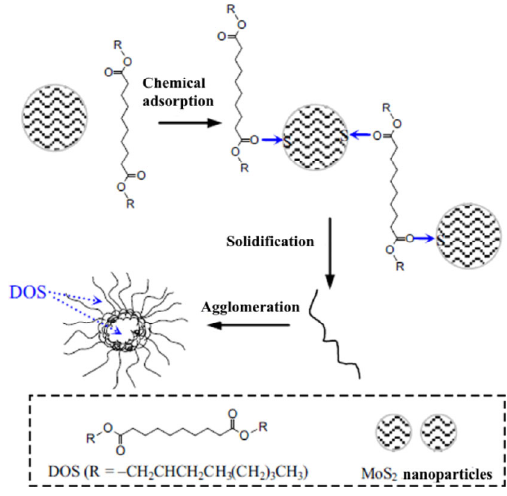
Fig. 6 Formation of adsorption layer using MoS 2 NPs [133].